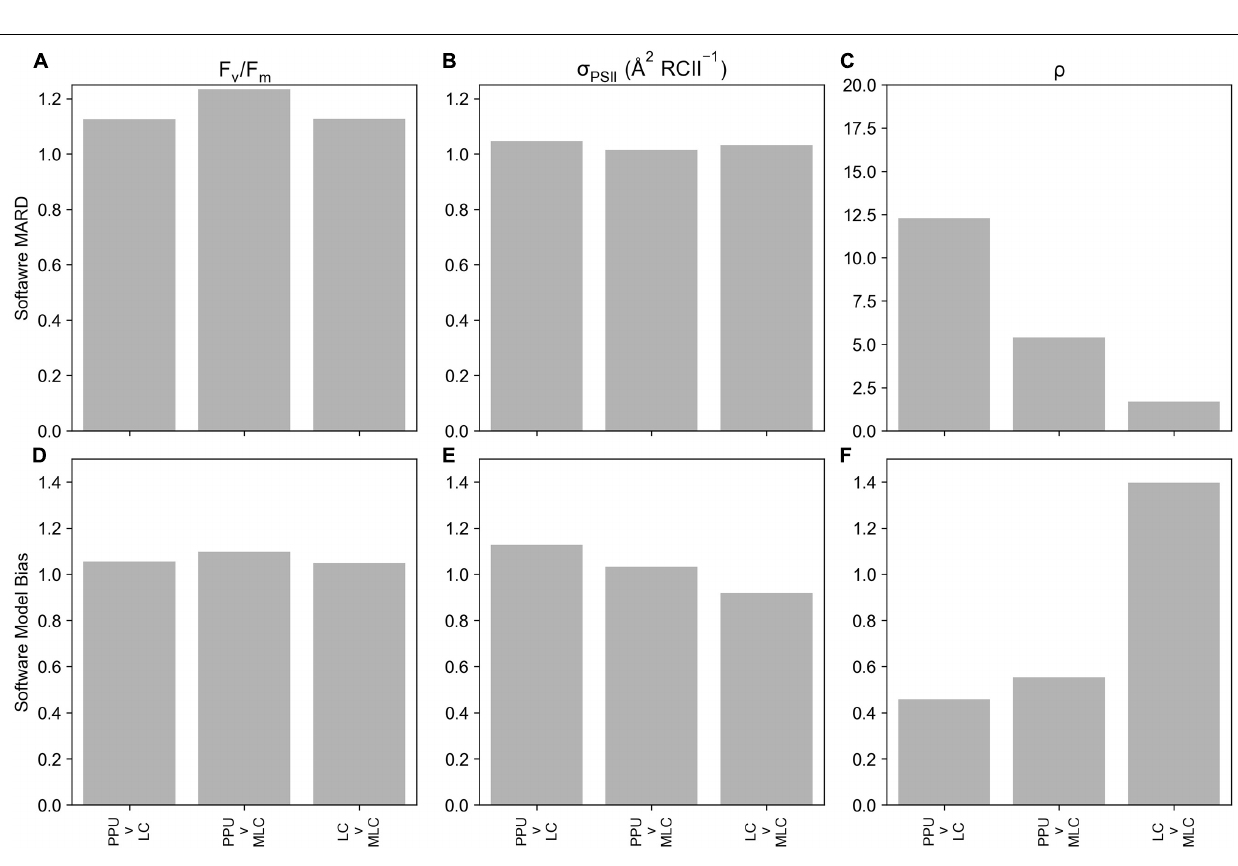
FIGURE 4 | Statistical metrics comparing parameters derived from PPU, Laney V6 Code (LC) and modified Laney V6 Code (MLC) processing of the D350 (FAST Tracka I) dataset from the North Atlantic. This includes the Software MARD (a-c) and Software Model Bias (d-f) for F v /F m (A,D) , σ PSII (B,E) and ρ (C,F) . Please note the different scale in panel